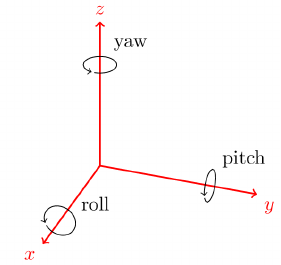
Figure 1. The IMU coordinate